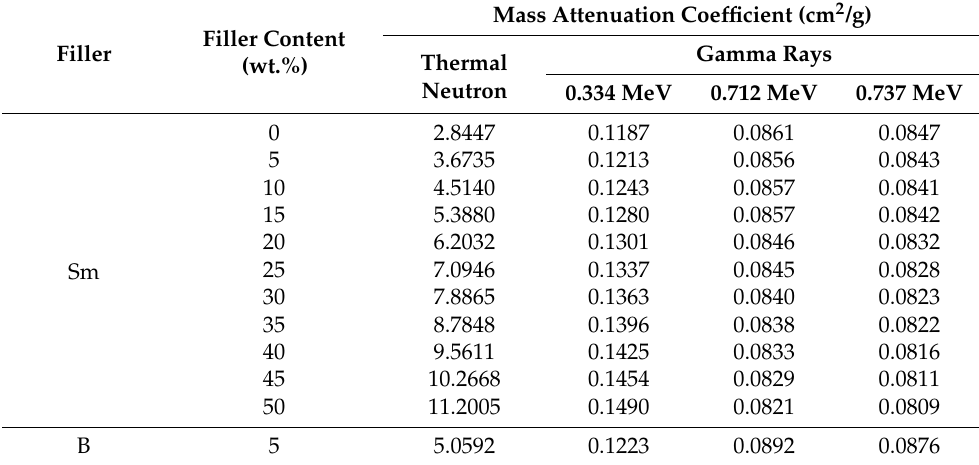
Table 6. Mass attenuation coefficients ( µ m ) for neutron and self-emitted gamma attenuation of Sm 2 O 3 /UHMWPE composites and a commercial 5% borated PE, determined by using PHITS. Filler Content Filler